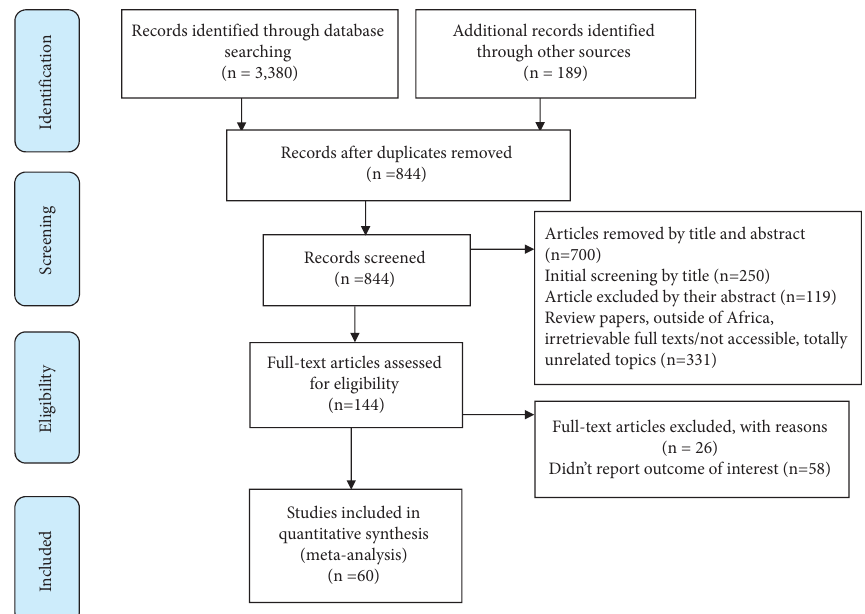
Figure 1: PRISMA-adapted fow diagram showing the results of the search and reasons for exclusion